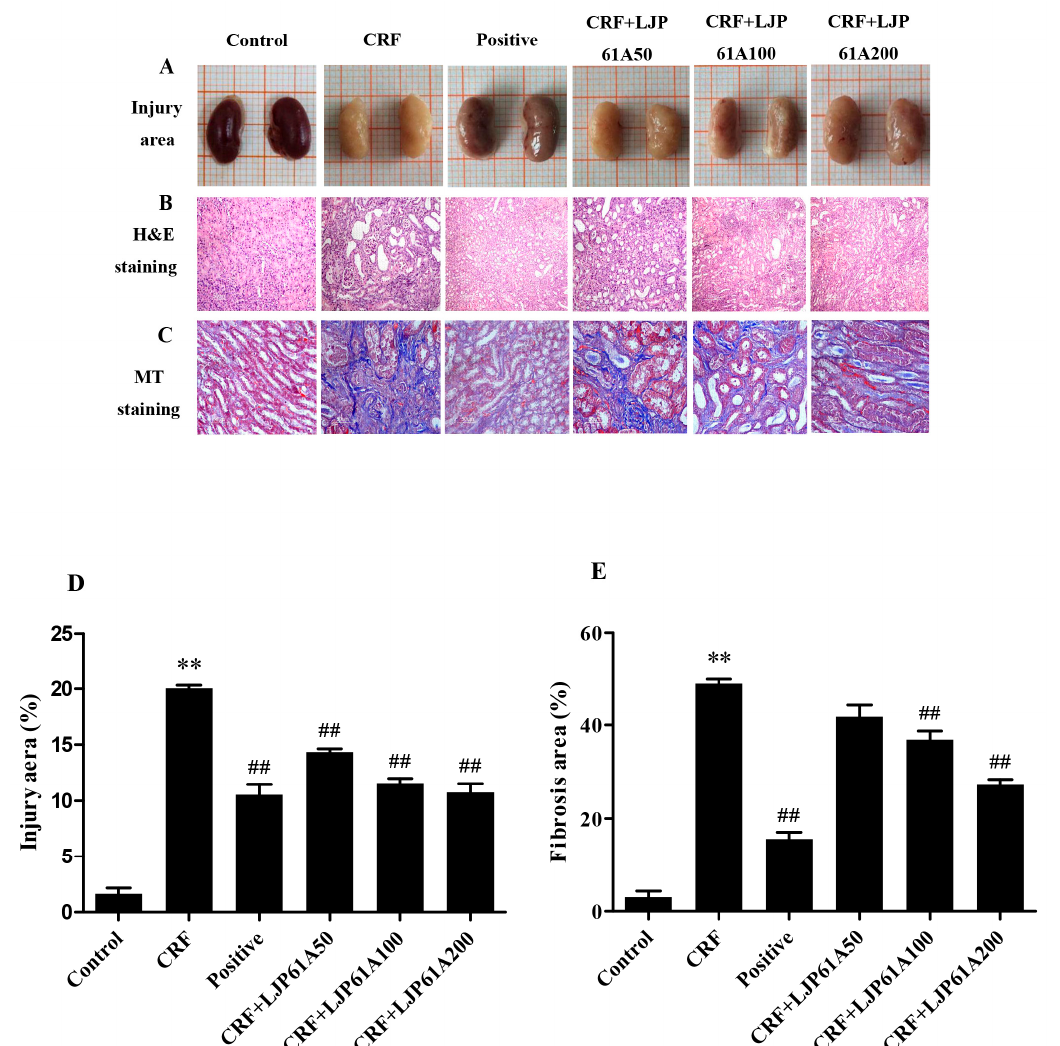
Figure 3. LJP61A ameliorates kidney injury in adenine-induced CRF mice. ( A ) Renal morphology; 10mm / grid ( B ) H&E staining; ( C ) MT staining; ( D ) injury area; ( E ) fibrosis aera. ** p < 0.01 (vs. Control group); ## p < 0.01 (vs. CRF group).